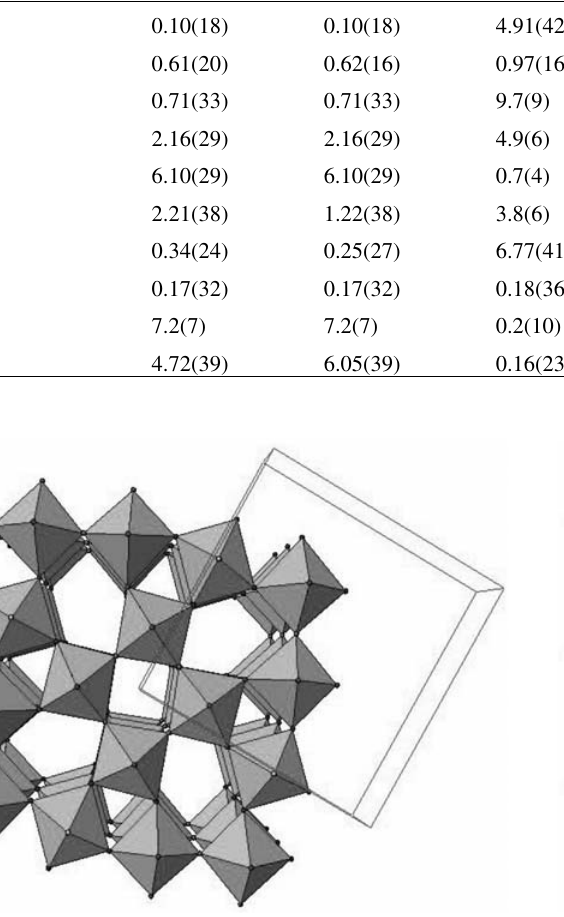
Figure 3. Octahedral representation obtained with the program Atoms for Windows using the refinement results.